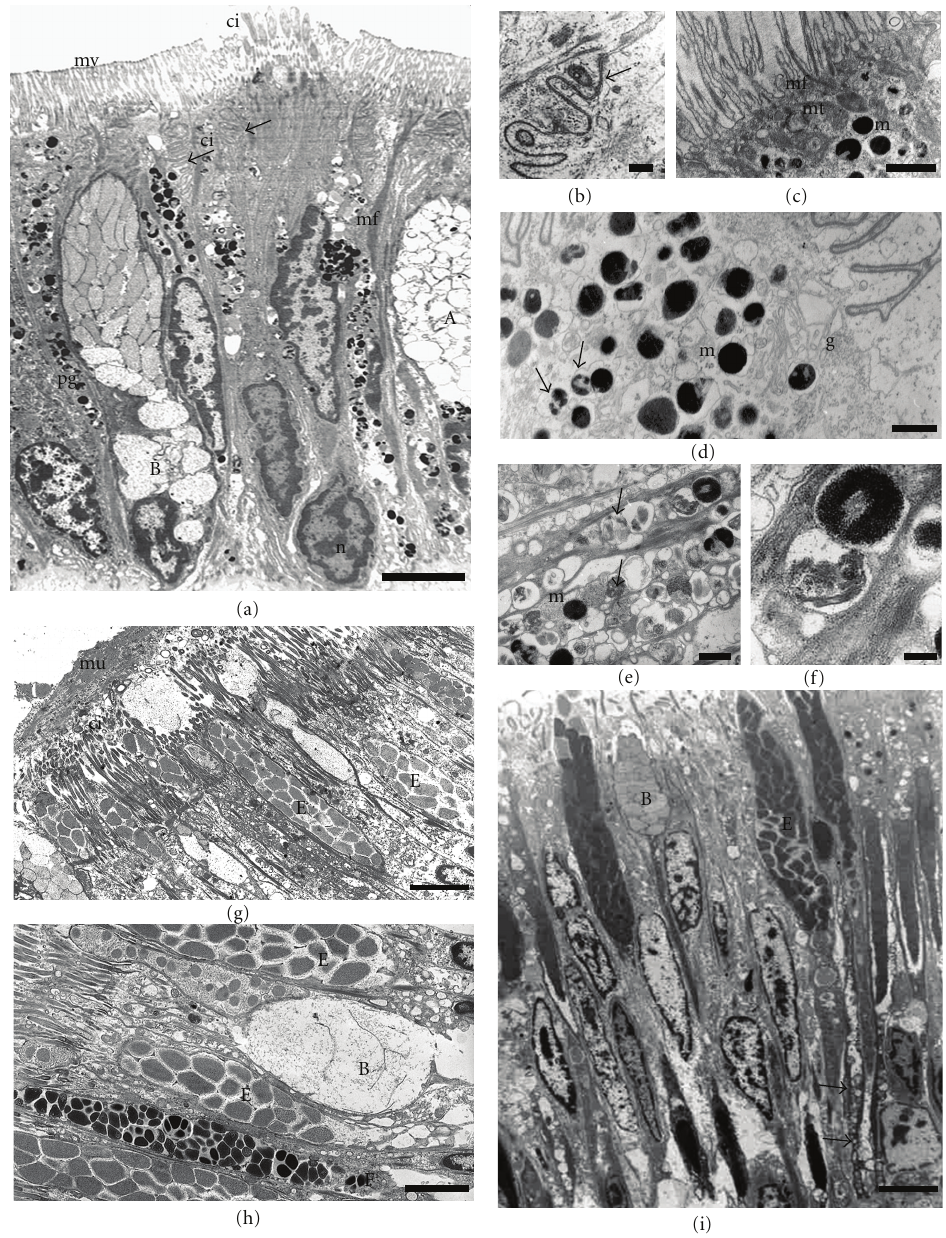
Figure 4: Transmission electron microphotographs of the side (a–f) and sole (g–i) foot epithelia. (a) General view showing secretory cells (types (a) and (b)) and pigmented epithelial cells with a prominent microvillus border (mv), a small group of cilia (ci) projecting from the apical surface. Note the highly infolded lateral membrane (arrows). Nucleus (n), pigmented granules (pg). Bar: 5 µ m. (b) Detail of the apical region of adjacent cells, cell junctions which a zonula adherens can be observed (arrow). Bar: 0.5 µ m. (c) Detail of microvillus border, microfilaments (mf) extend from the apical surface and comprise the core of the microvilli. At the apical surface mitochondria (mt) and melanosomes (m) are concentrated. Bar: 5 µ m. (d) Melanosomes (m) and partially melanized granules (arrows) from a pigmented cell located on a groove. Golgi complex (g) Bar: 1 µ m. (e) A pigmented epithelial cell located on the crests showing phycobilin-like pigmented granules (arrows) and a few melanosomes at di ff erent developmental stages (m) Bar: 0.3 µ m. (f) Detail of both pigmented granules. Bar: 0.1 µ m. (g) The mucus (mu) layer over the ciliated sole cells. Cilia (ci) Bar: 3 µ m. (h) Three types of secretory cells (B, E, F) interspersed with ciliated cells. Bar: 2 µ m. (i) General view of the ciliated sole foot epithelium. Type (b) and (e) secretory cells are located among ciliated epithelial cells. Observe the long necks (arrows) extending to the basal membrane. Bar: 3 µ